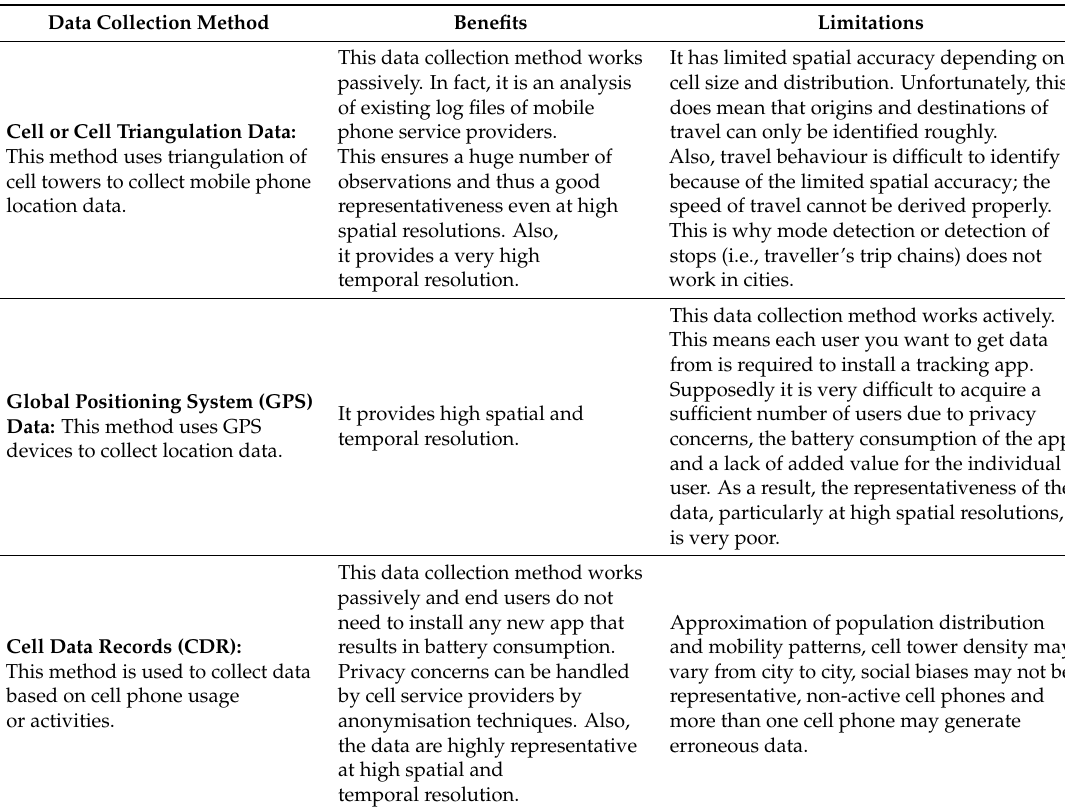
Table 2. Mobile phone data collection methods for population distribution and